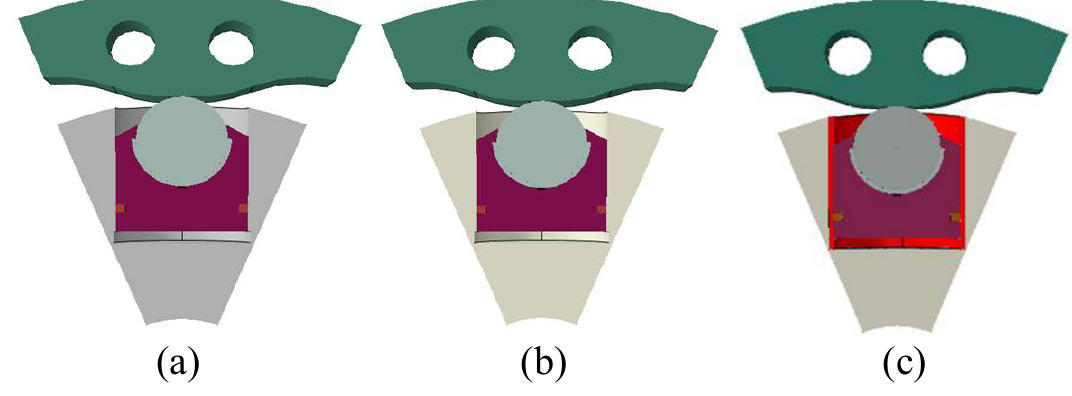
Figure 6. ( a ) Steel, ( b ) aluminum, and ( c ) composite cylinder motor assembly models.